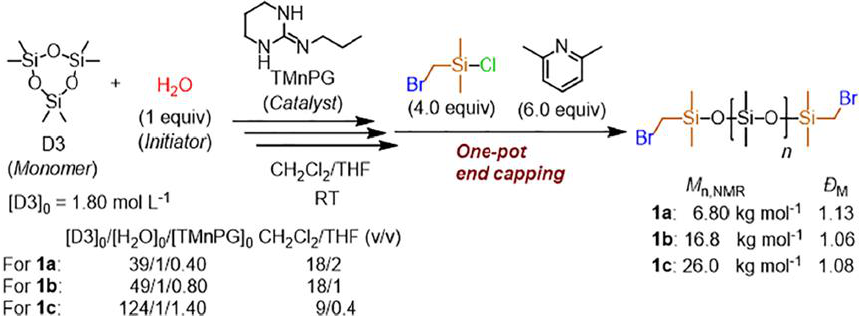
Figure 20. Synthesis of α , ω -chain-end-functionalized PDMS with bromomethyl groups (Br-PDMS-Br: 1a/1b/1c) by the controlled ring-opening polymerization of hexamethylcyclotrisiloxane (D3) cat- alyzed by 1,3-trimethylene-2-n-propylguanidine (TMnPG) (adapted with permission from Ref. [109], 2021, Sato, K.I)